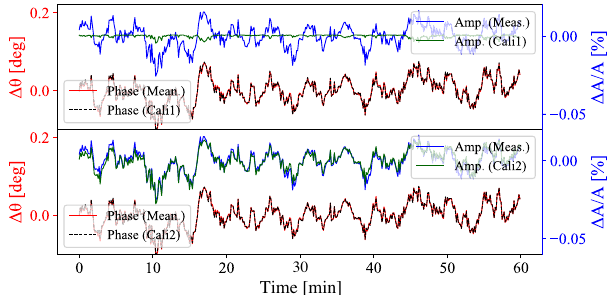
and K were deter- org org and K were selected as the new new